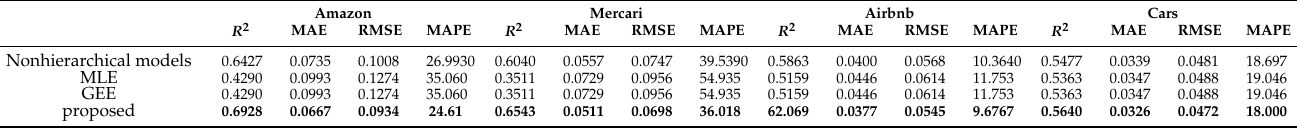
Table 2. Hierarchical vs. non-hierarchical regression models.